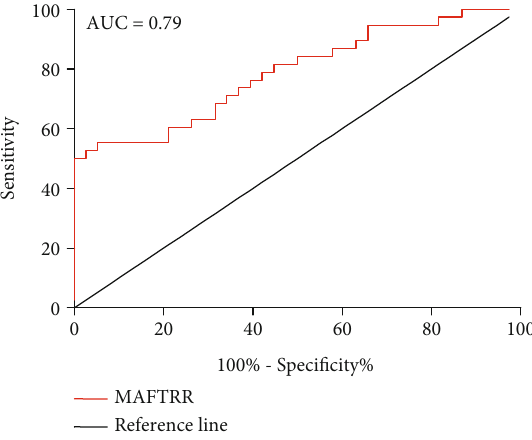
Figure 5: Potential diagnostic value of MAFTRR in HT. The ROC curve analysis of MAFTRR was performed to distinguish the HT patients from the healthy